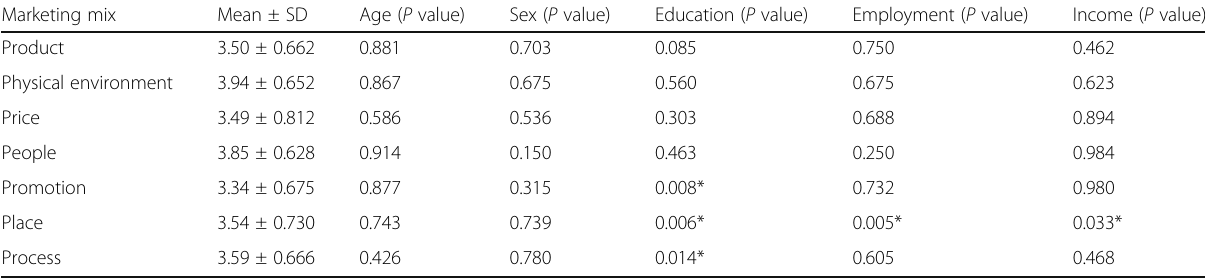
Table 4 The relationship between demographic variables and 7Ps Marketing